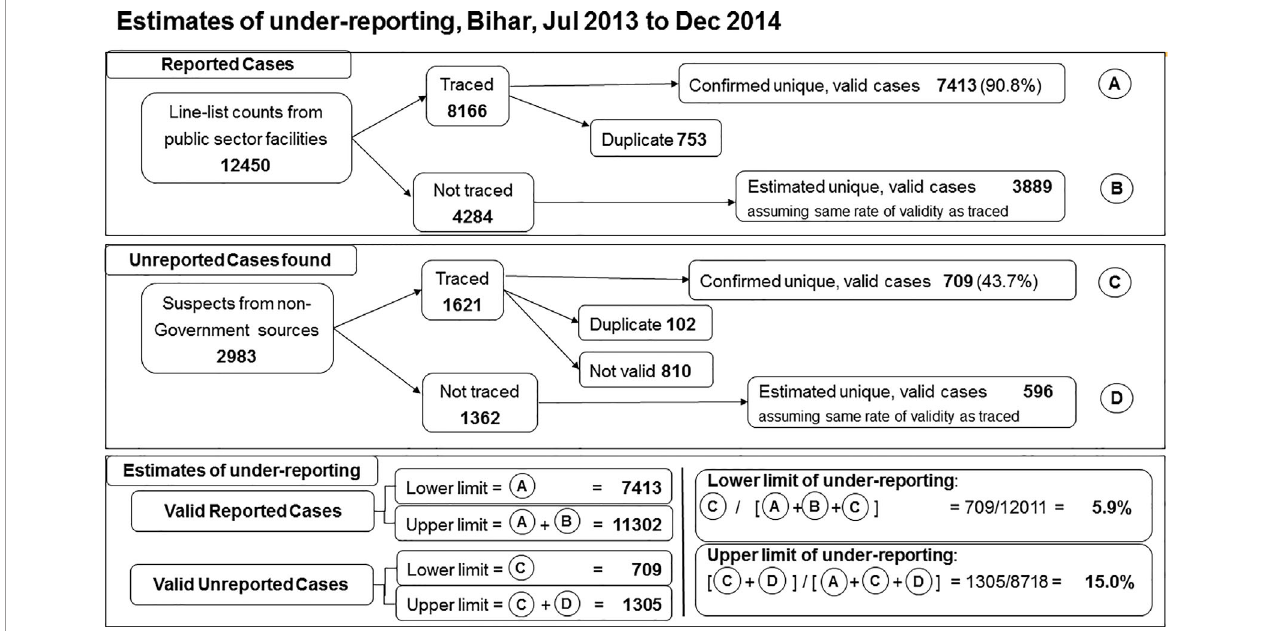
FIGURE 4 | Estimates of visceral leishmaniasis under-reporting, 33 endemic districts of Bihar, July 2013-December 2014. A total of 12,450 cases were extracted from the line list of visceral leishmaniasis cases treated at public sector facilities during the study period, of which 8166 were traced and 7413 of those validated (A) . Assuming the untraced cases had the same rate of validity as the traced cases yields an additional 3889 potentially valid cases (B) . From non-government sources 2983 suspected cases were identi fi ed, of which 1621 were traced and 709 validated as unreported cases (C) . Assuming the same rate of validity as for traced suspects yields 596 potentially valid unreported cases (D) . Based on these data, the validated case fi gure was estimated to range between 7413 and 13,013 (A to A+B), while unreported case fi gure was between 709 and 1305 (C to C+D). Using the extremes of these estimated ranges, underreporting was estimated between 5.9% and